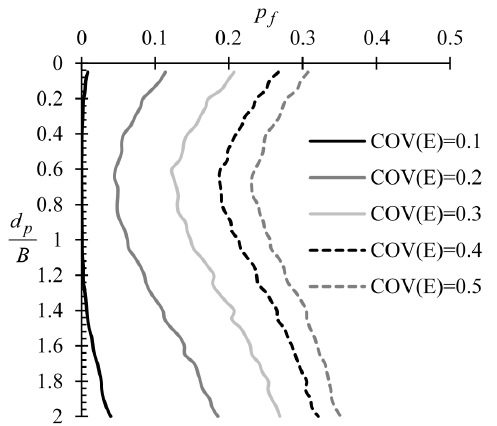
θ / B = 10, x / B = 0 and di ff erent values of COV of E